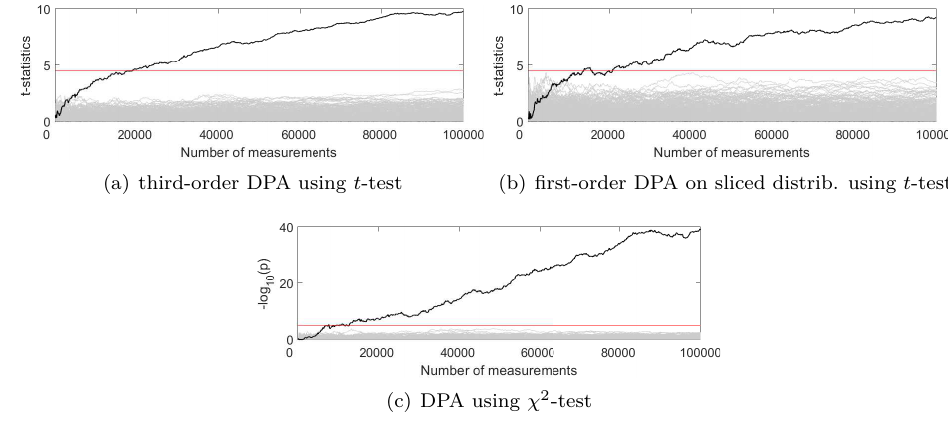
Figure 18: Same attacks as in Figure 16, but with only 200,000 traces and running the LFSR-based PRNG, responsible for delivering the fresh randomness, during the measurements to minimize algorithmic